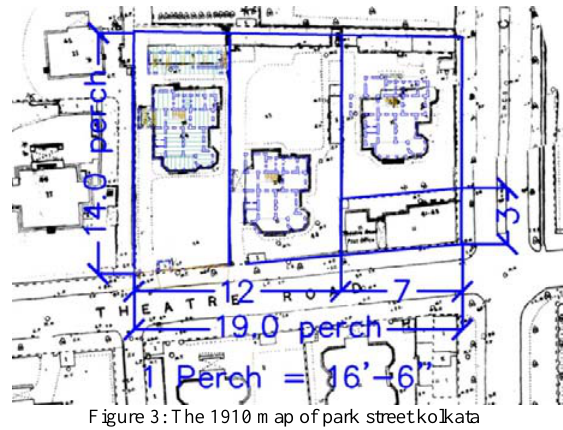
Figure 3: The 1910 map of park street kolkata